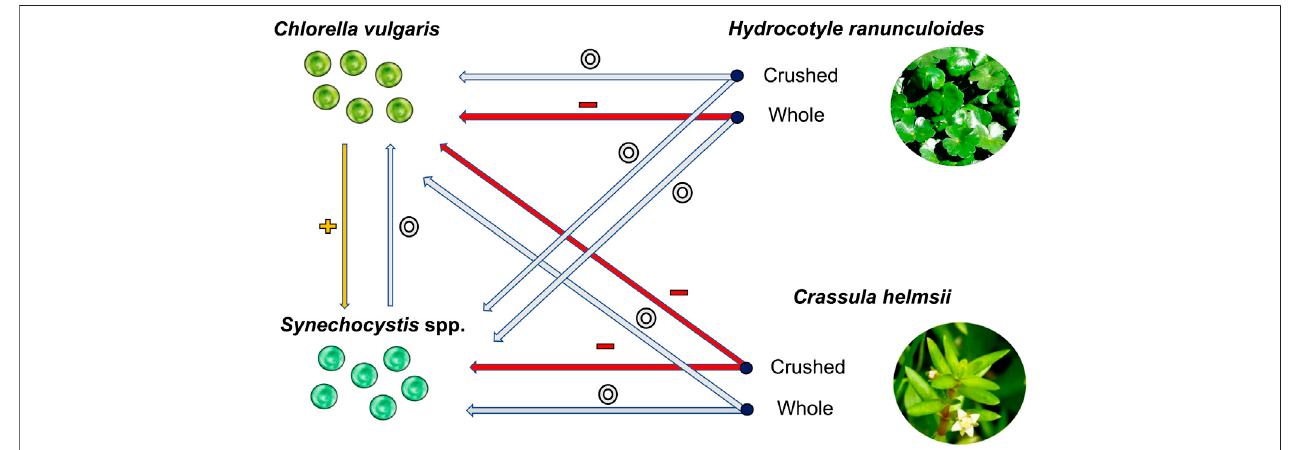
FIGURE 2 | A simpli fi ed diagram of the interactions between the different plant species, plant states and phytoplankton species. The arrows indicate interactions between the plants and phytoplankton. All interactions relate to effects on the average population growth for the indicated phytoplankton species. The red arrows accompanied by the ( − ) symbol indicate negative interactions; the grey arrows accompanied by the (o) symbol indicate neutral interactions; and the yellow arrows